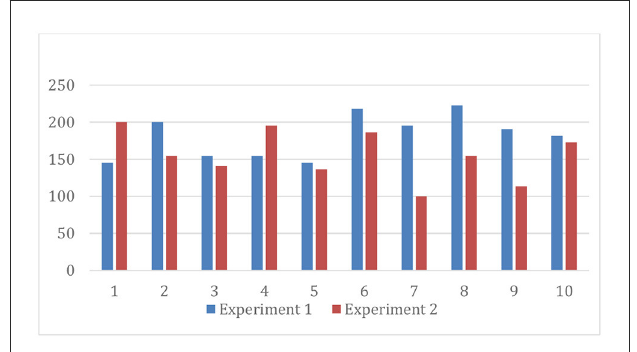
FIGURE1 Average contributions in each round.